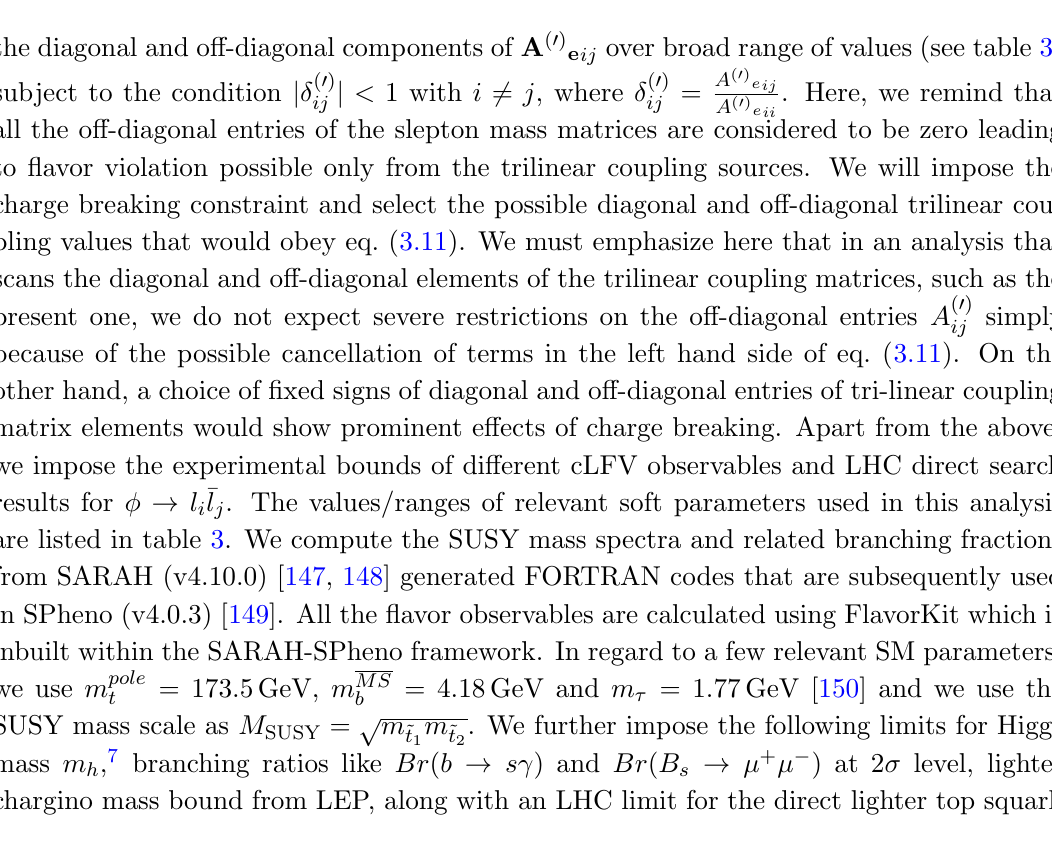
the diagonal and o(cid:11)-diagonal components of A ( 0 )